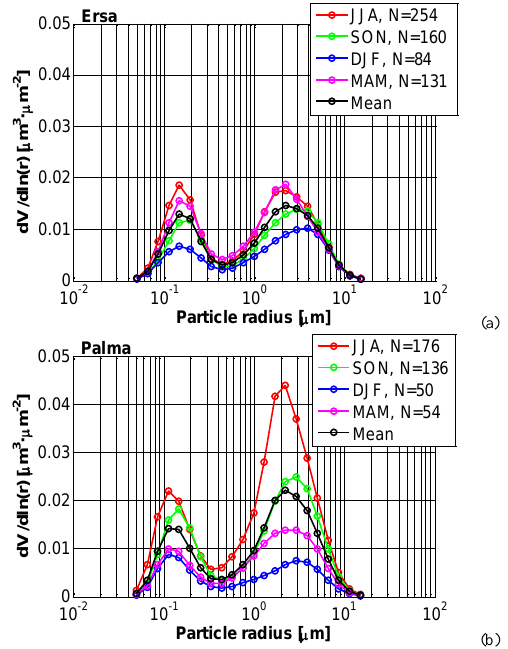
Figure 7. Seasonal variation of the particle volume size distribu- tion in the atmospheric column at (a) Ersa and (b) Palma derived from AERONET level 2.0 daily inversion products available for the period